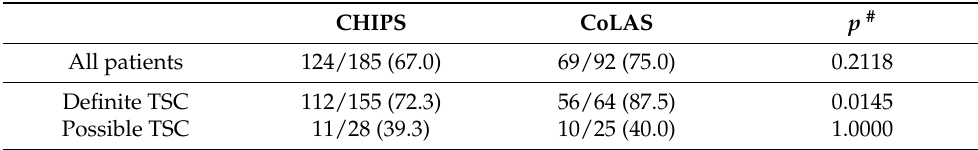
Table 11. Mutation detection rate by screening method.